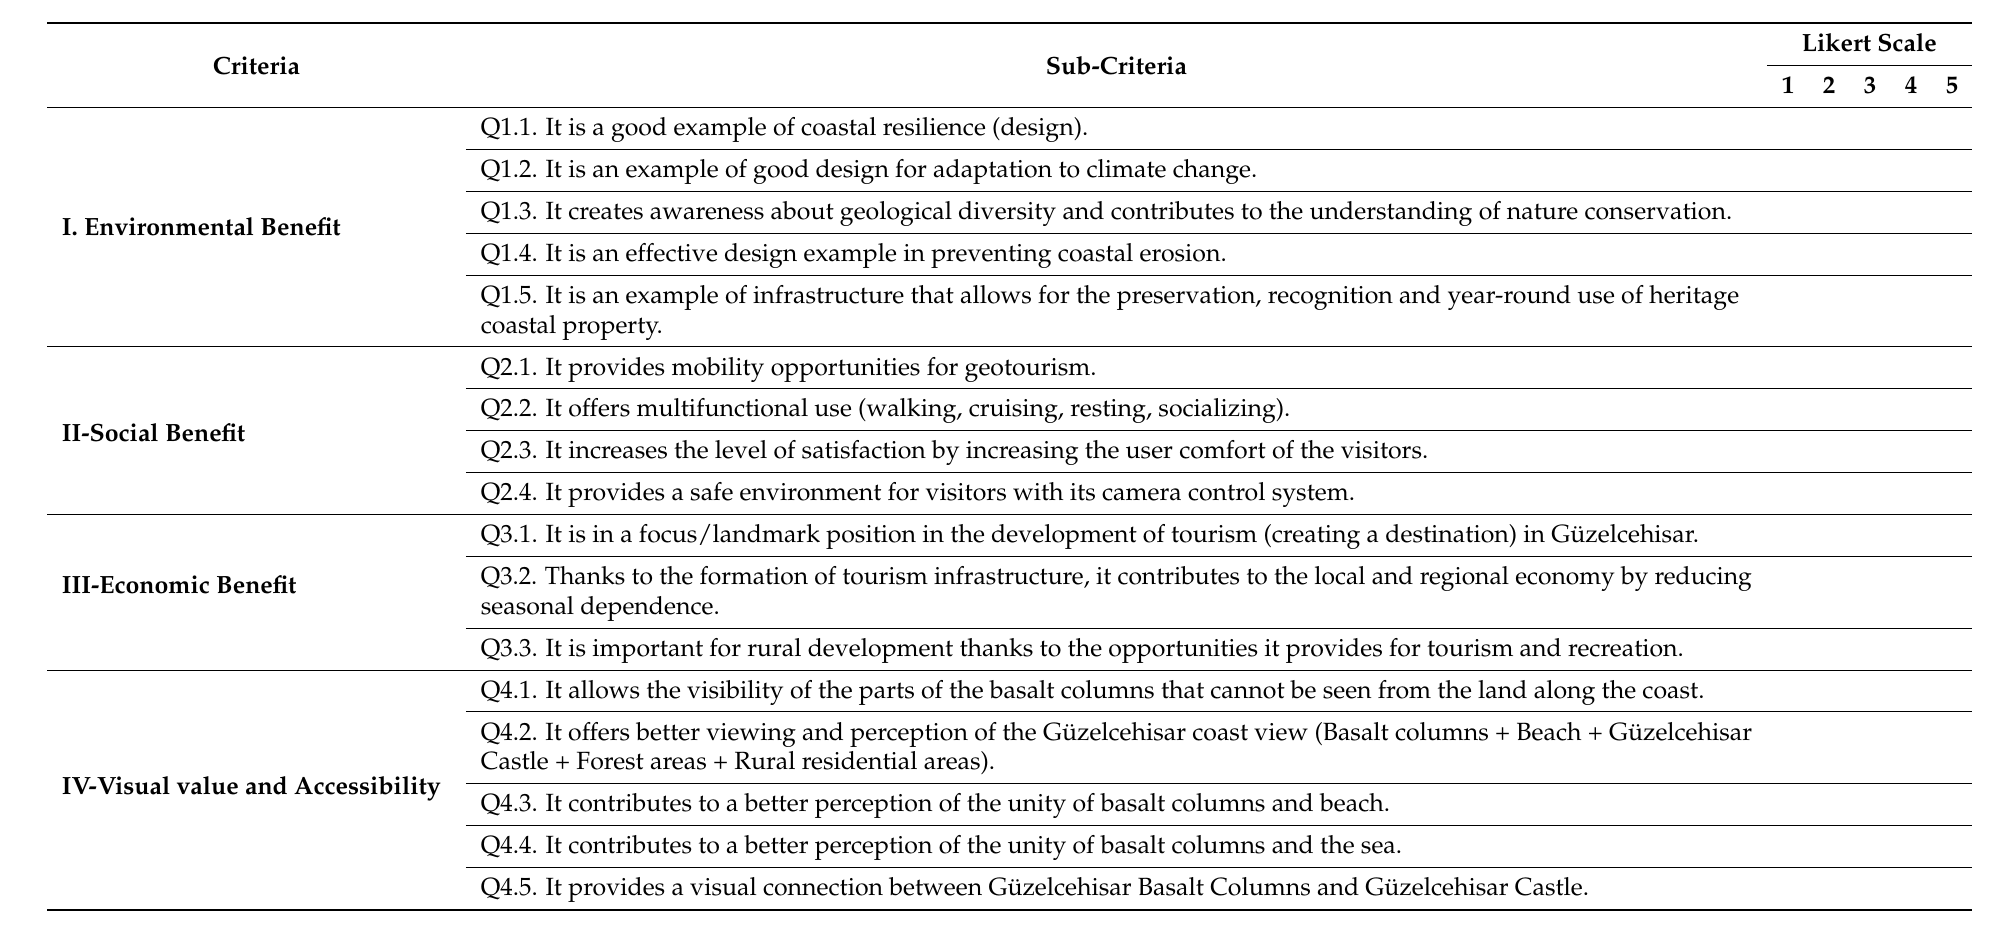
Table 1. Criteria and its